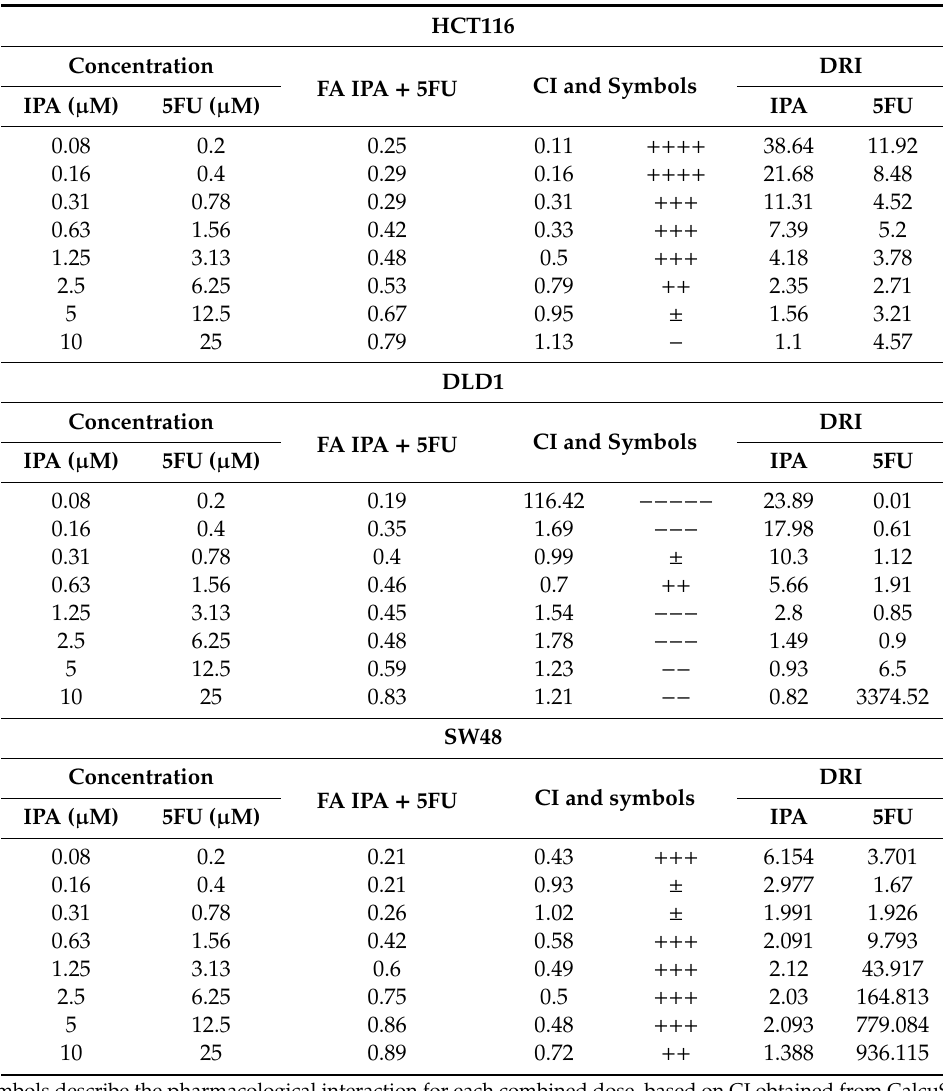
Table 1. IPA synergizes with 5FU. Fraction A ff ected (FA), Combination Index (CI) and Dose Reduction Index (DRI) for IPA and 5FU combination (constant molar ratio 1:2.5) in HCT116, DLD1 and SW48